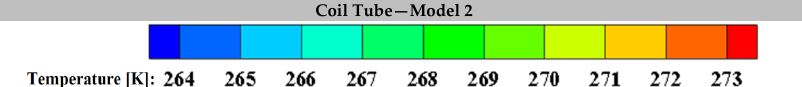
Figure 9. Contours of temperature (K) at five various slices in the computational domain for the different investigated models in the horizontal position.